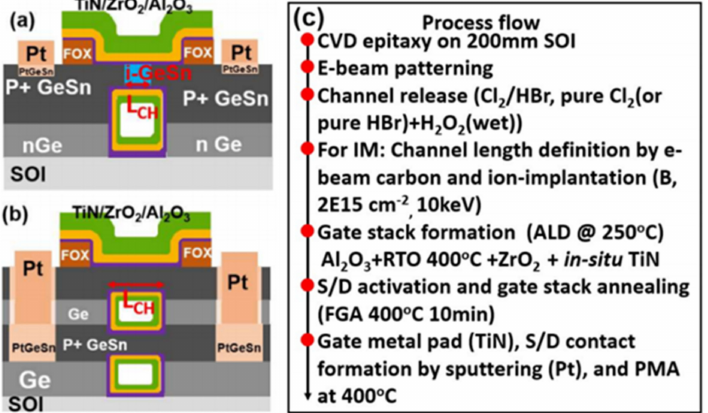
Figure 41. Schematic cross-sectional view of ( a ) single GeSn channel, ( b ) stacked GeSn nanowire pGAAFETs, and ( c ) process flow for devices. Reproduced with permission from [214], IEEE, 2017.